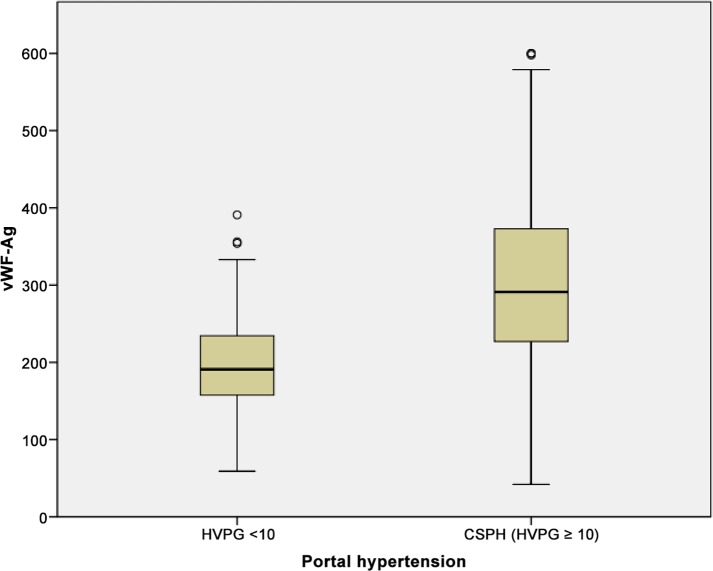
Correlation of Von Willebrand factor antigen (vWF-Ag) and CSPH.Mean values of vWF-Ag shown in boxplots for a cohort of patients with and without CSPH each.